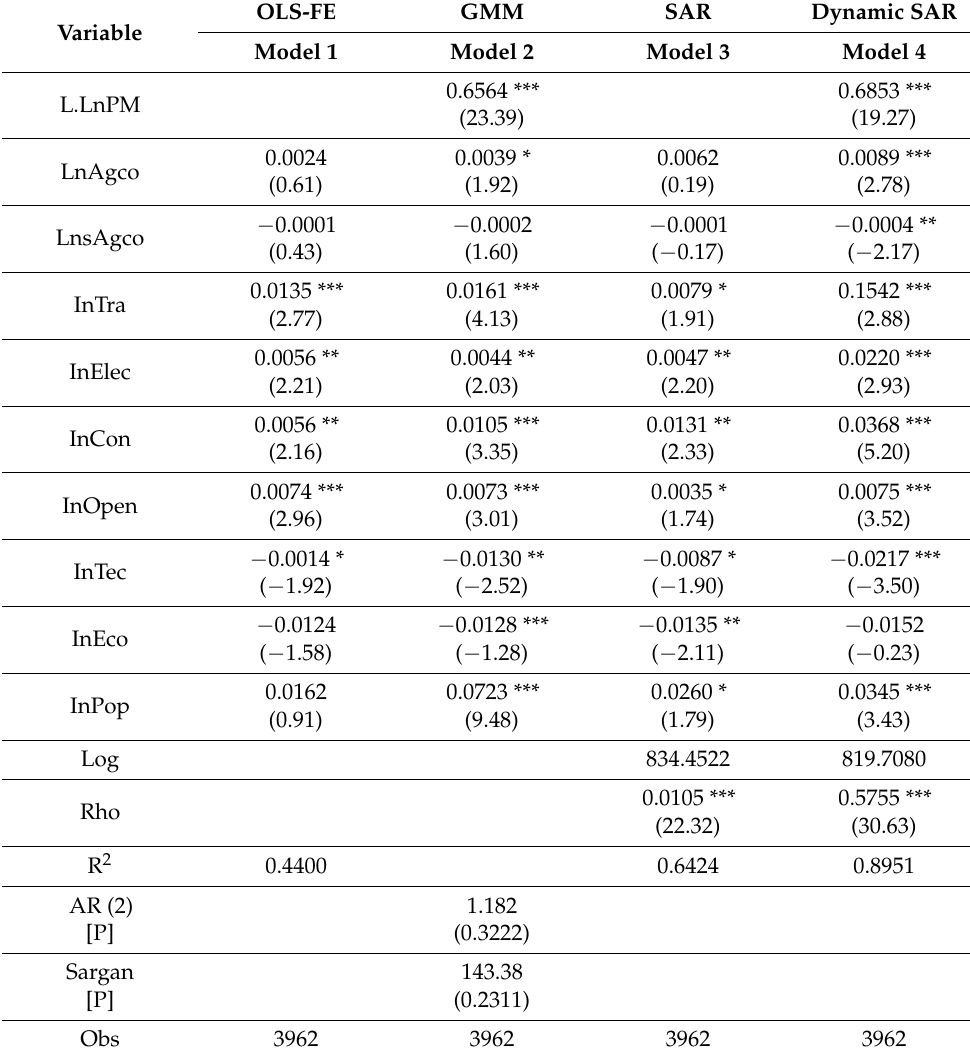
Table 3. The impact of industrial co-agglomeration on haze